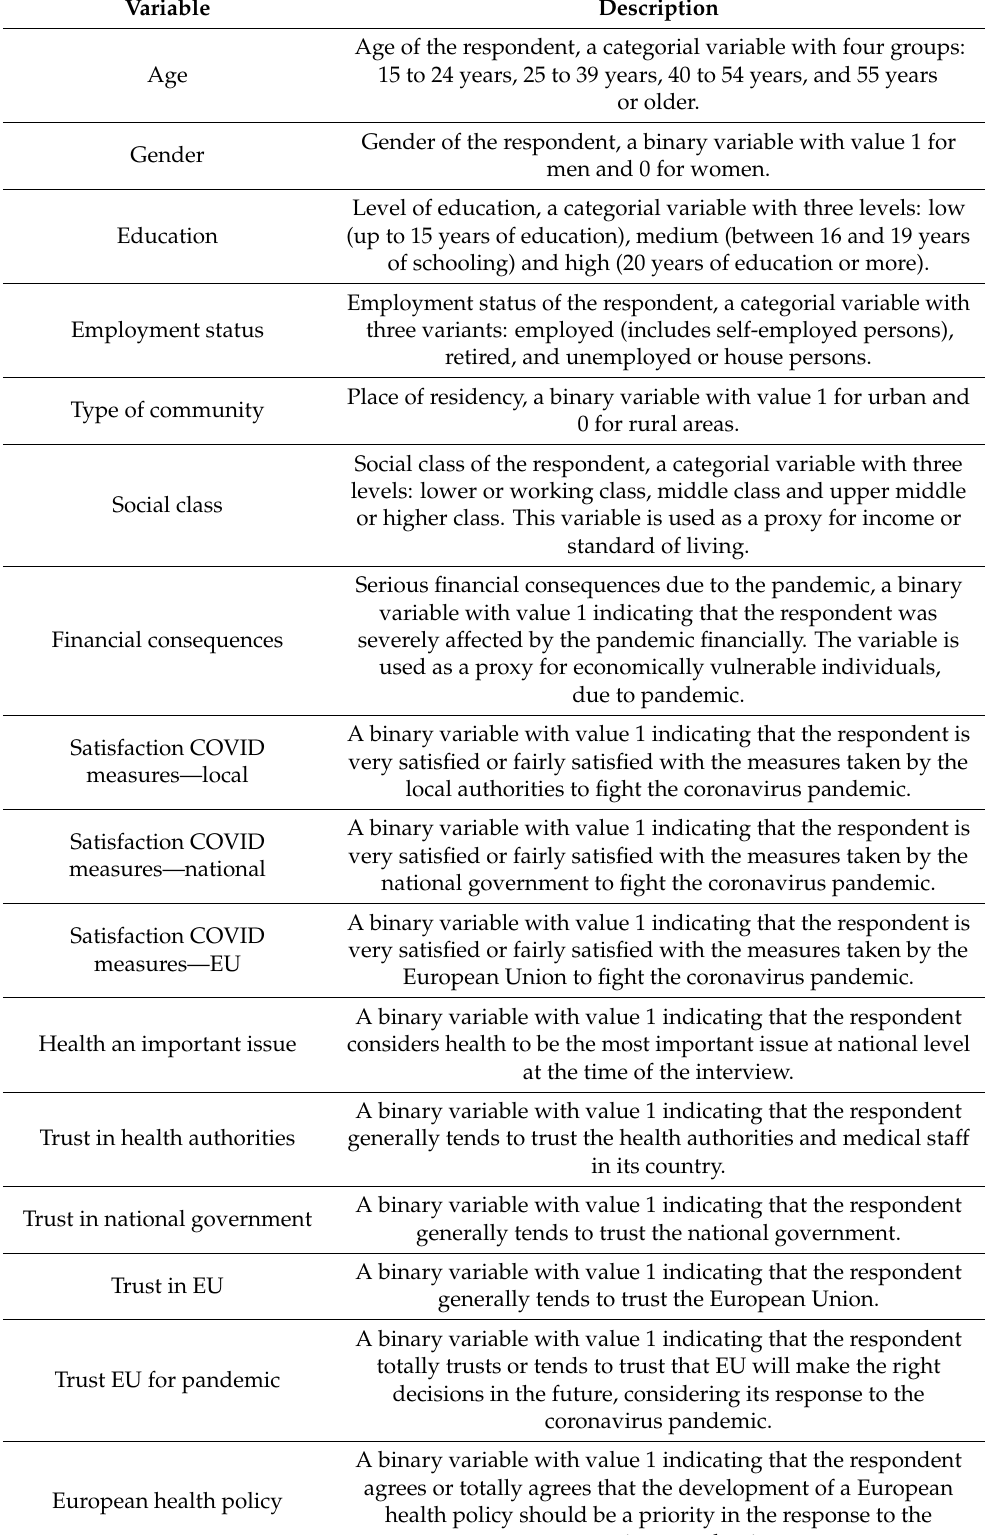
Table 1. The description of